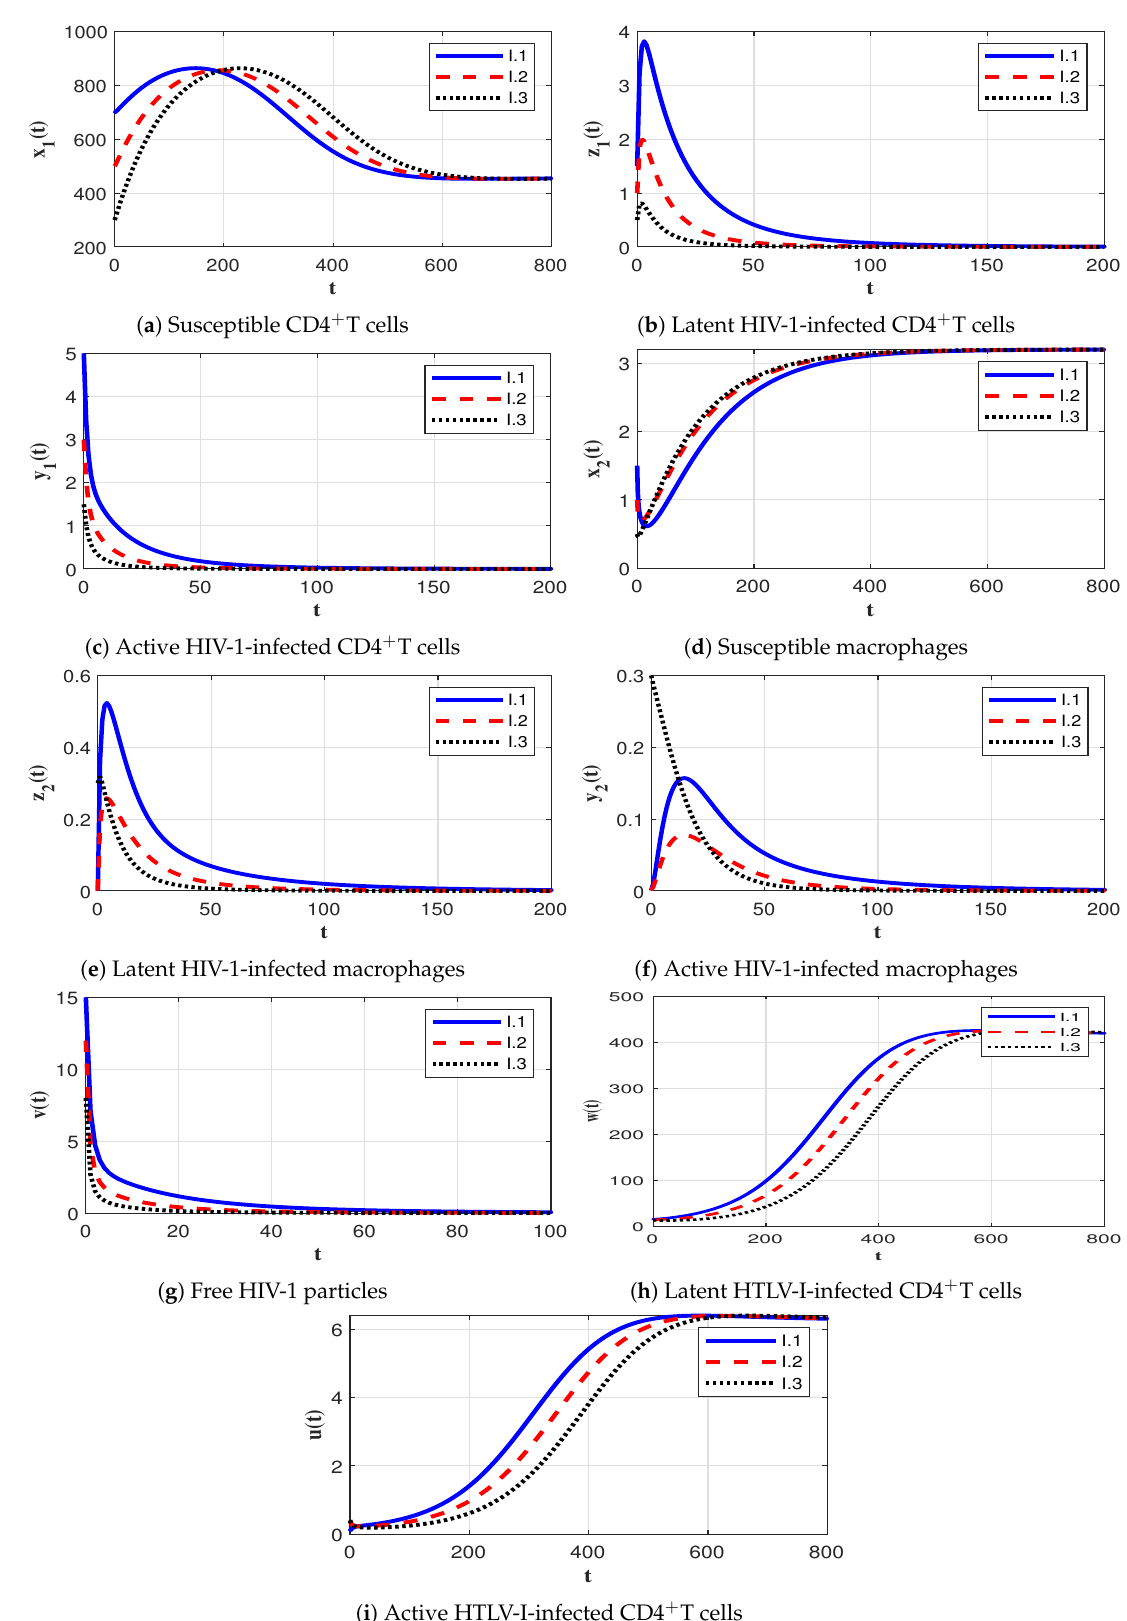
Figure 4. The equilibrium EP 2 = ( 453.96,0,0,3.19,0,0,0,420.72,6.31 ) is G.A.S whenever R 1 > 1 and R 01 + R 02 R 1 ≤ R 1